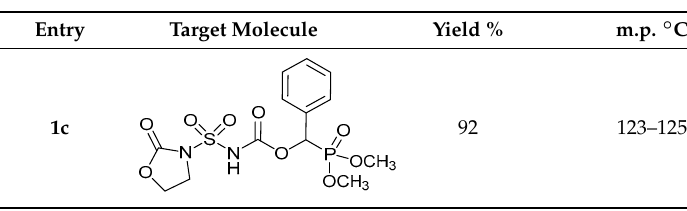
Table 3. Physical data and yield for the sulfamidocarbonyloxyphosphonate 1c synthesized from oxazolidin-2-one.